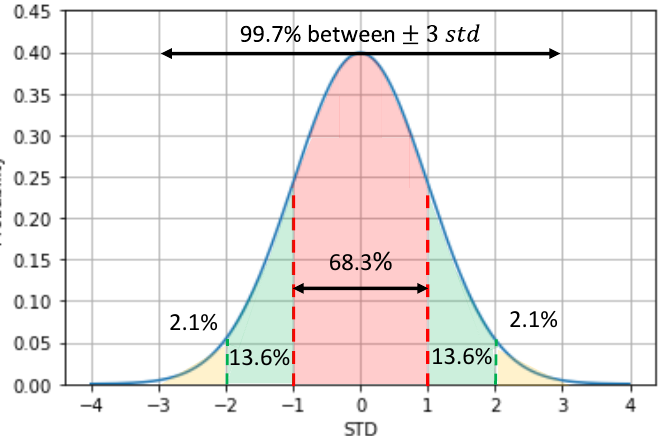
Figure 1. Percentages in normal distribution between standard deviations. Based on Straker [19].